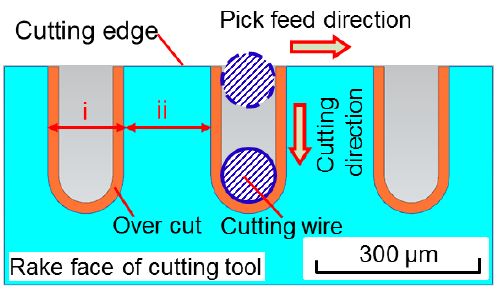
Figure 4. Machined micro structures on tool cutting edge by applying wire cut electrical discharge machining (WEDM).